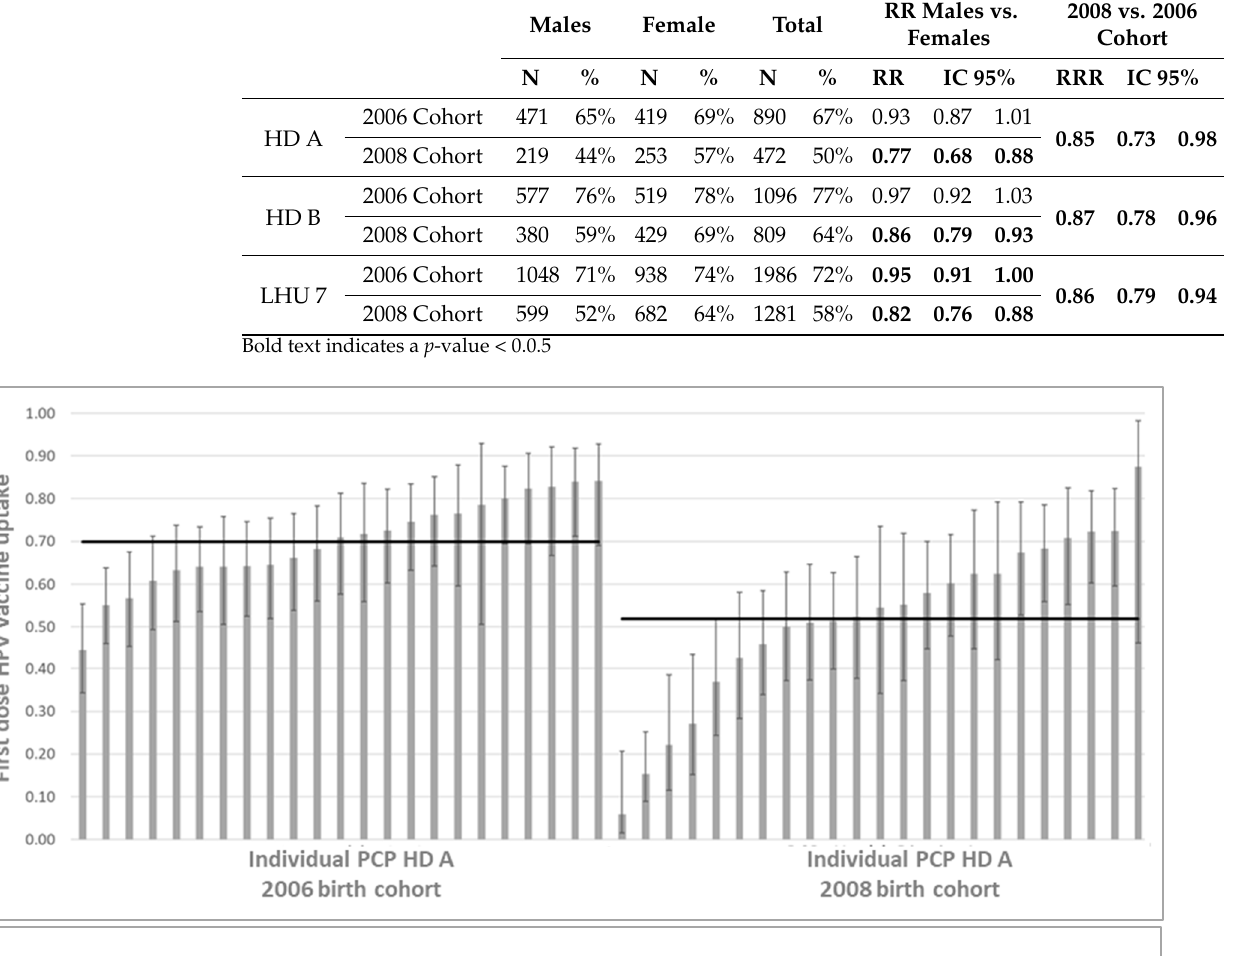
Table 2. First dose of HPV among 12-year-old boys and girls born in 2006 and 2008 assisted by a primary care pediatrician, Local Health Unit 7, Veneto region. RR Males vs. 2008 vs. 2006 Males Female Total Females Cohort N % N % N % RR IC 95% RRR IC 95%